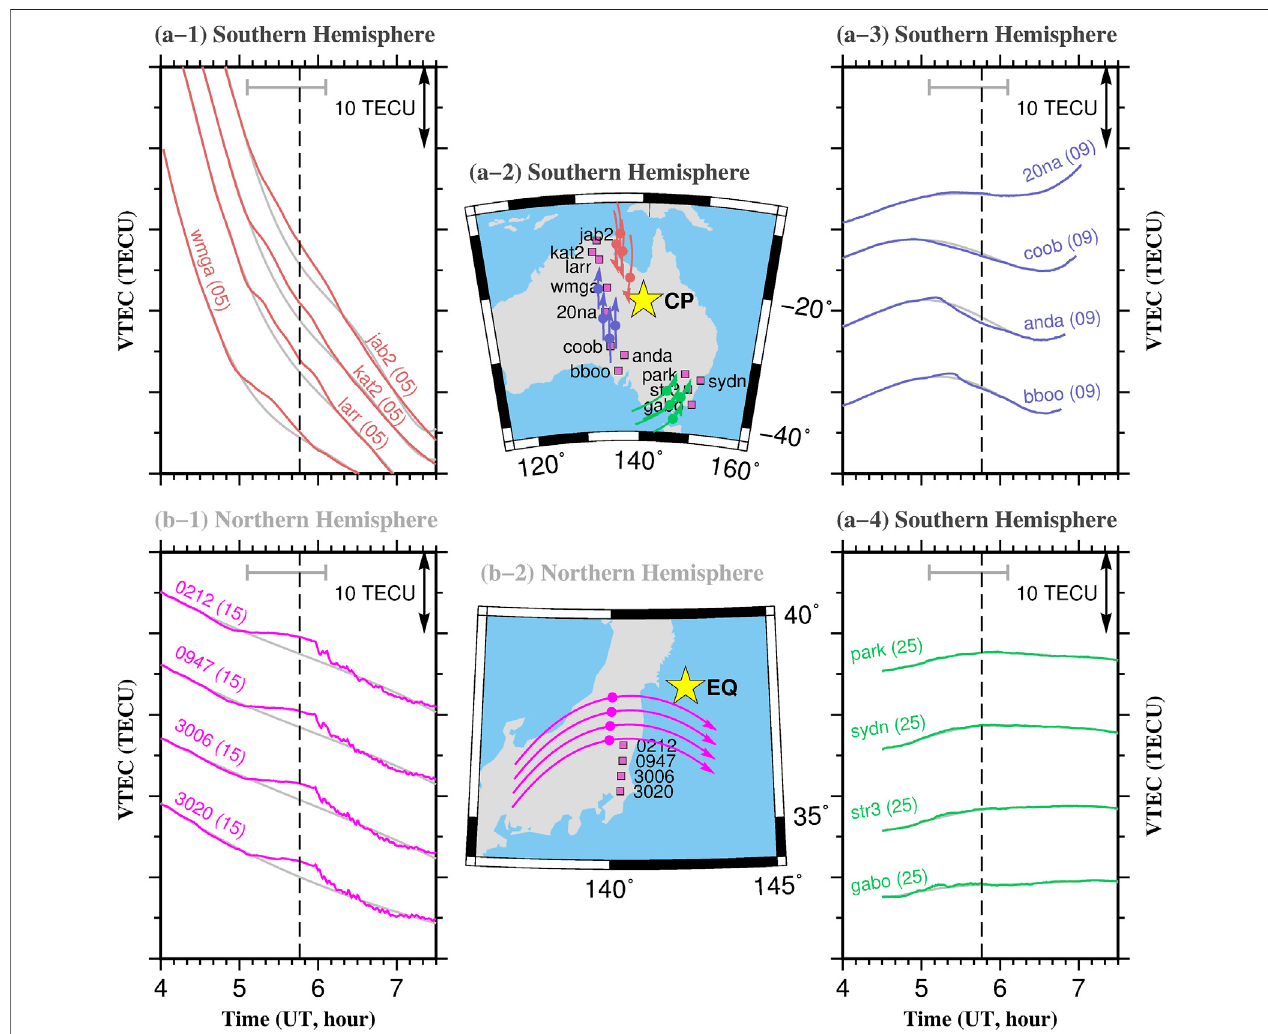
FIGURE 2 | VTEC time series observed using four satellite-station pairs on 11 March 2011 in Australia showing preseismic ionospheric enhancements (A-1) around CP, and no signi fi cant changes (A-3, A-4) . We also show four VTEC time series (b-1) observed in Japan showing preseismic enhancements, which is the VTEC version of Figure 2 in Heki (2011). The vertical dashed lines show the occurrence of the 2011 Tohoku-oki earthquake. The gray horizontal bars represent the exclusion windows in de fi ning the reference curves. The two maps in the middle panel show the locations of GNSS stations (pink squares) and sub-ionospheric point (SIP) trajectories in Australia (A-2) and in Japan (B-2) . The circles on the tracks indicate the SIP positions at the earthquake occurrence time. The yellow stars show the epicenter (B-2) and it is CP (A-2) . We assume the ionospheric height at 350 km to draw the SIP trajectories.